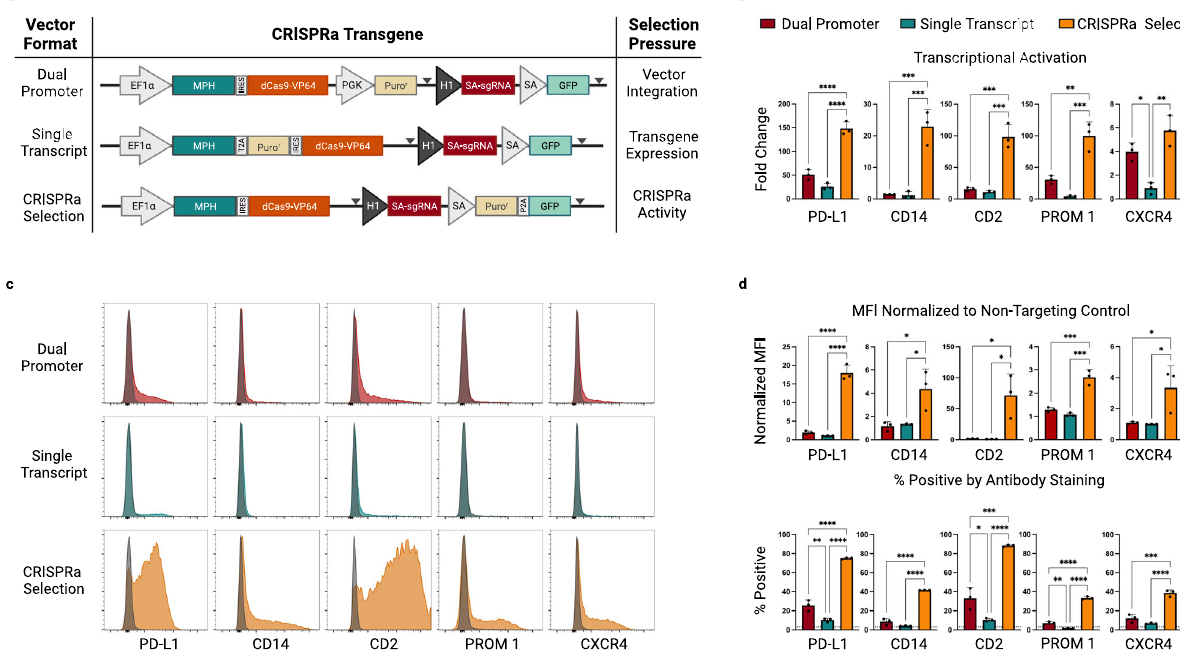
Fig. 1 | A self-selecting CRISPRa piggyBac vector for the rapid generation of stable, high-ef fi ciency CRISPRa cell populations. a Vector format and selective strategy for the evaluated piggyBac CRISPRa expression-reporter vectors. Expres- sion of the MCP-P65-HSF1 (MPH) activator and dCas9-VP64 is driven by a con- stitutive, human EF1 α promoter. A human H1 promoter drives constitutive expression of a sgRNA complementary to the self-activating (SA) promoter upstream of a GFP reporter. Expression of a Puro r gene is driven either by its own constitutivepromoter(dualpromoter),transcriptionallylinkedtotheMPH/dCas9- VP64 (single transcript) or under control of the CRISPRa dependent SA promoter (CRISPRa selection). Gray triangles indicate the location of LoxP sites. PiggyBac engineered K562 populations were generated in triplicate ( n =3 biologically inde- pendent samples) for each vector format and enriched with Puromycin selection. sgRNAs complementary to the promoter proximal region of the indicated genes were cloned into a lentiviral vector context containing a mTagBFP2/Zeocin selec- tioncassette (SupplementaryFig.1b).Following transductionand Zeocinselection target gene expression was evaluated by quantitative RT-PCR (qRT-PCR) ( b ),